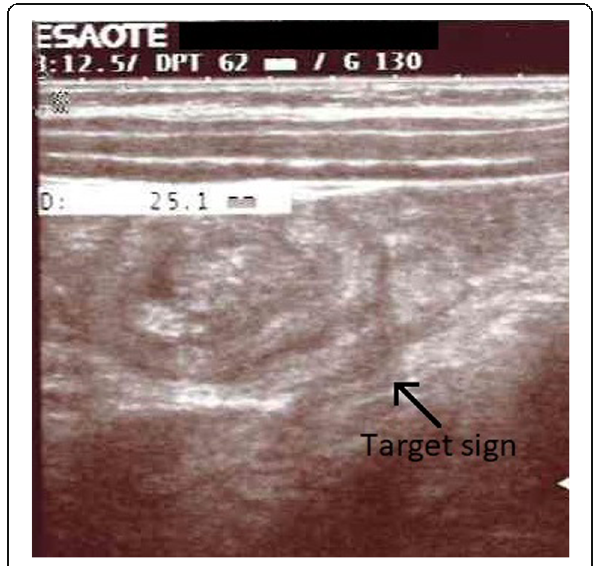
Fig. 1 Transverse ultrasonographic section of ileo-ileal intussusception producing the “ target ” sign (black arrow). The diameter of the lesion is 25